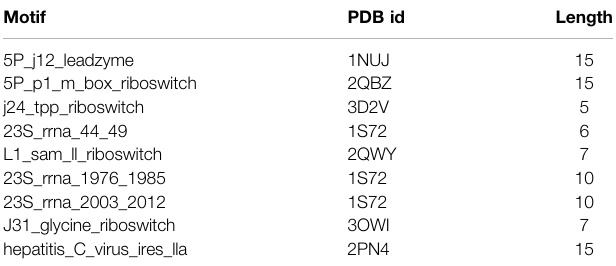
TABLE 1 | RNA motif from the PDB database.